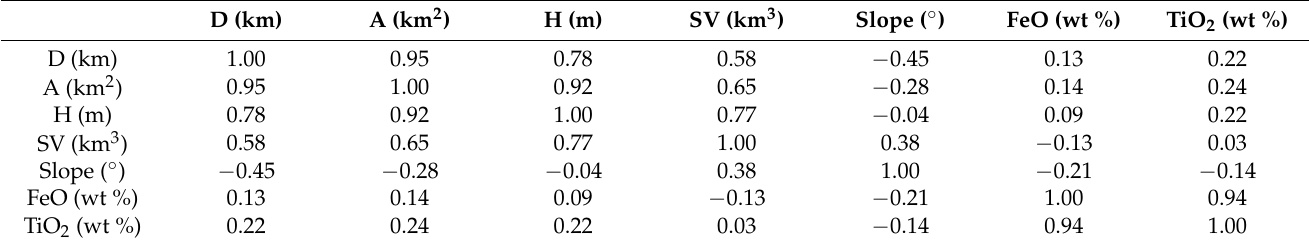
Table A2. Feature correlation coefficients of all the 54 domes.